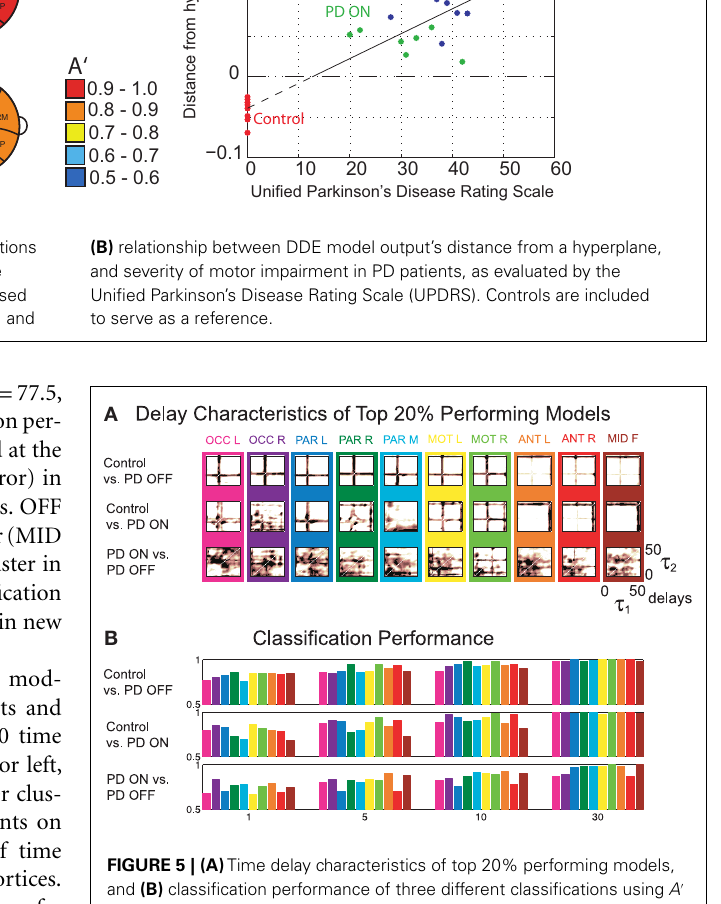
off medication( A (cid:48) = 0.74 − 0.82),andPDpatientsonmedications and controls ( A (cid:48) = 0.69 − 0.76) with a classification performance well above